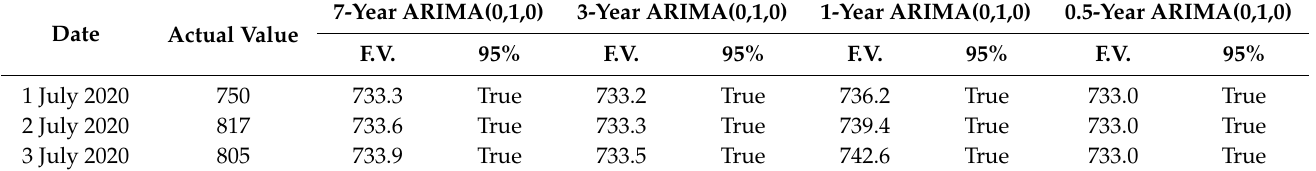
Table 5. Comparison of the predicted and actual values of each data interval for 3293 IGS.